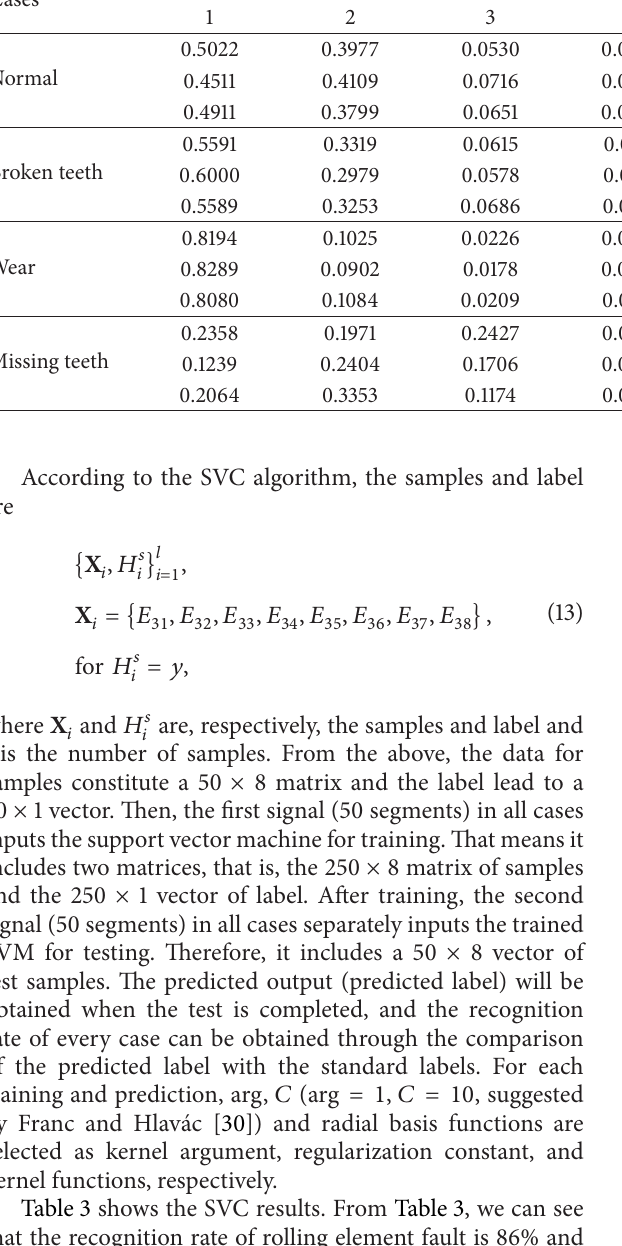
case, the broken teeth case, the wear case, and the missing teeth case as 1 to 4,